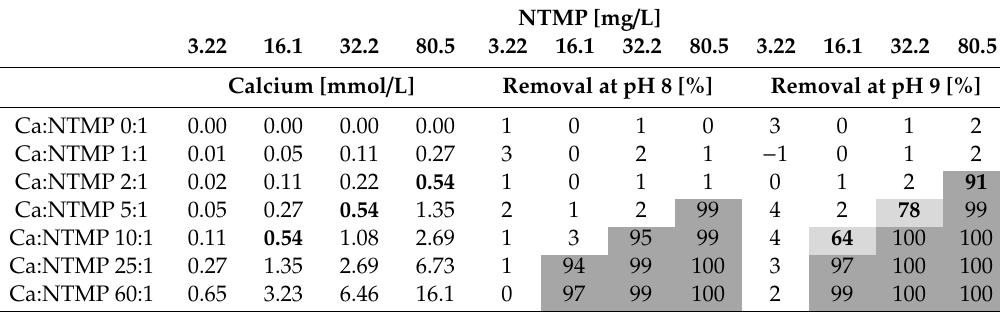
Table 4. Removal of NTMP by precipitation at di ff erent calcium concentrations and pH values (T = 20 ◦ C; t = 7 d; no GFH added). Standard deviations are shown in Table S1. c